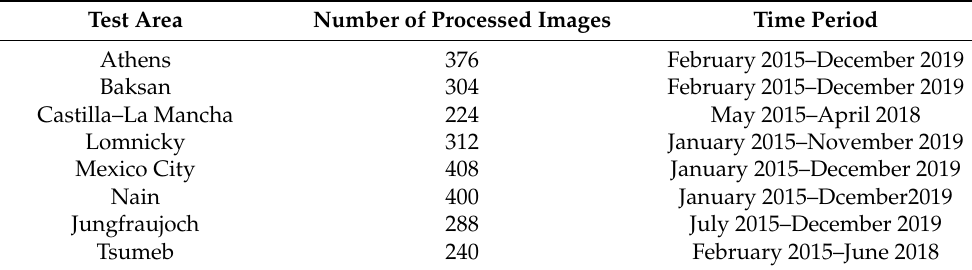
Table 1. Number of processed images and time periods.